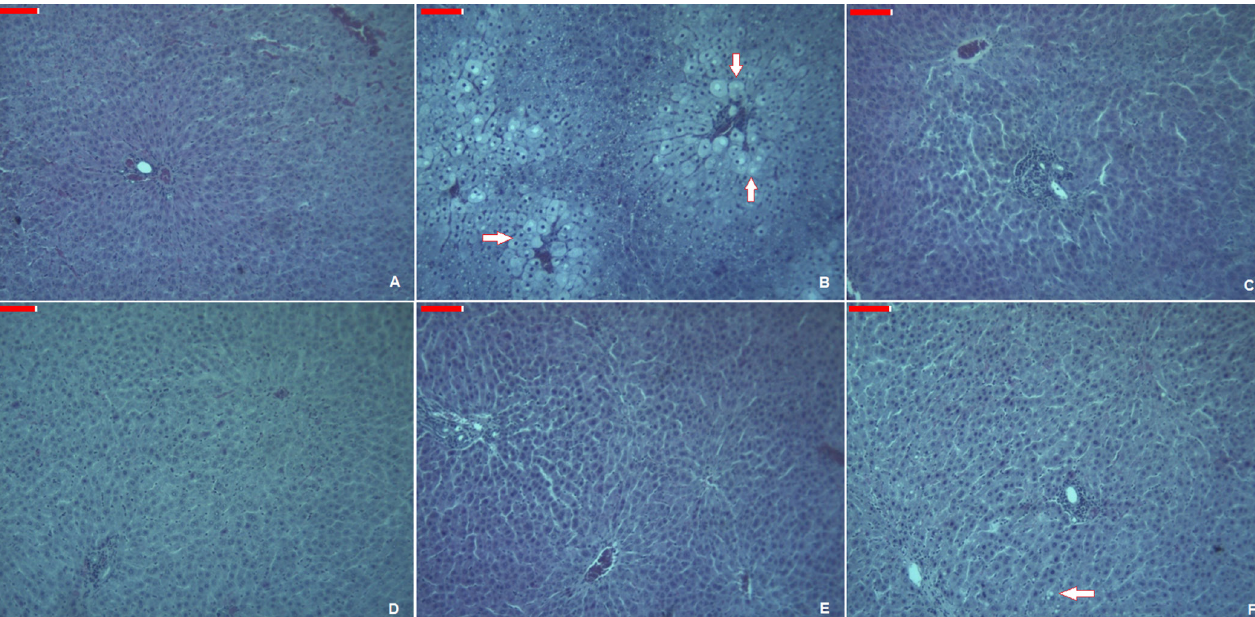
FIGURE 3 - Microscopic observations of livers stained with H&E (scale bars 66.67 µ m, on 40x): A. Liver tissue from control rats treated with olive oil alone revealed normal cellular architecture; B. Liver tissue of CCl of centriacinar and micro vesicular accumulation of fats; C. Liver tissue of AF treated group – normal cellular architecture; D. Liver tissue of silymarin treated group – normal cellular architecture; E. Liver tissue from rats challenged with CCl